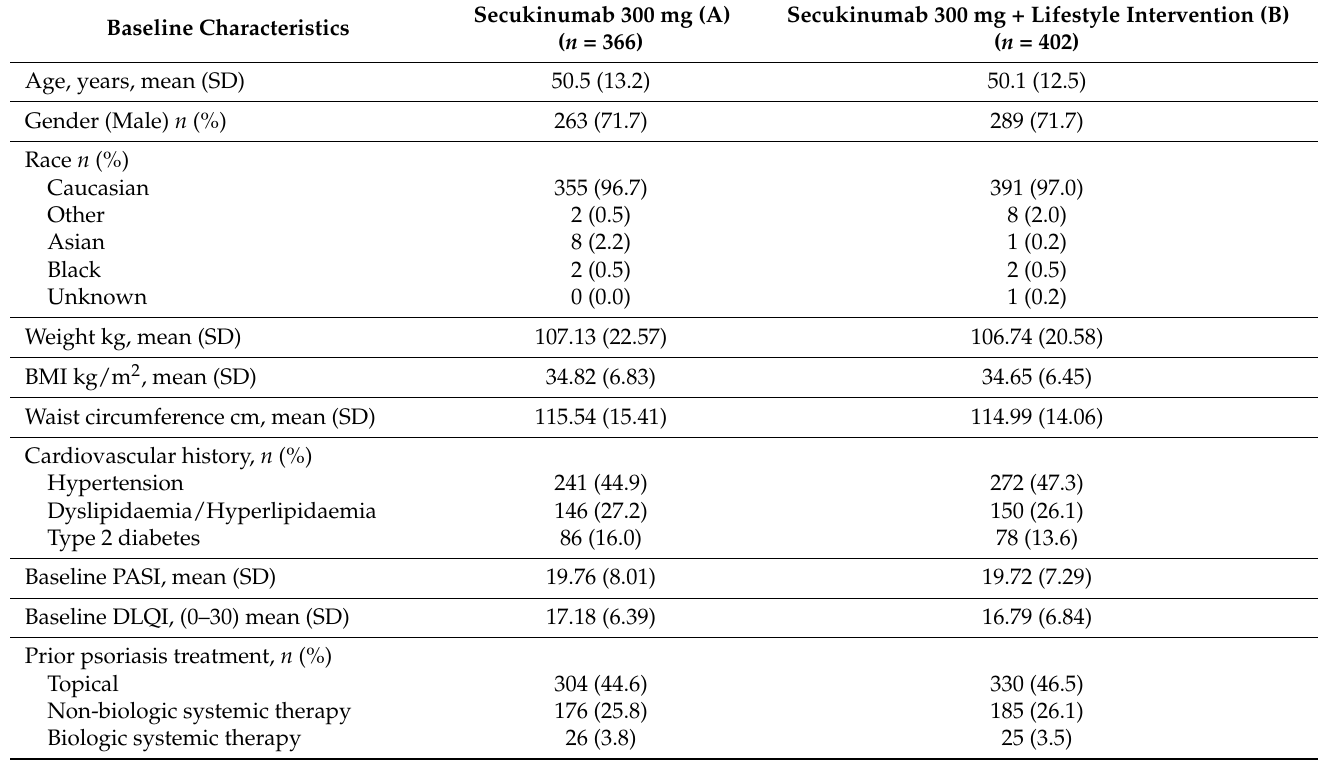
Table 4. Baseline characteristics of METABOLyx study population ( n =